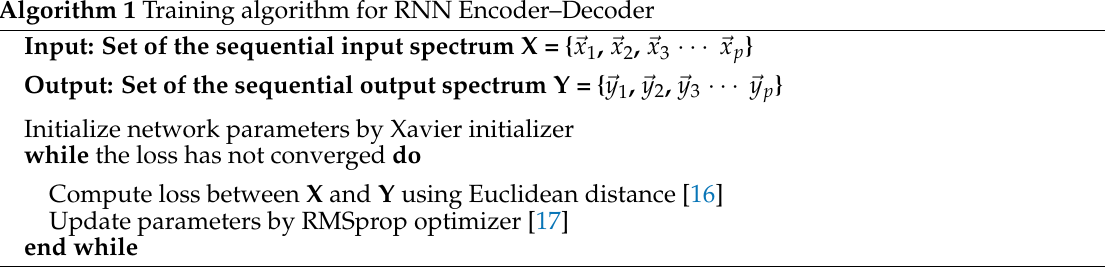
Algorithm 1 Training algorithm for RNN